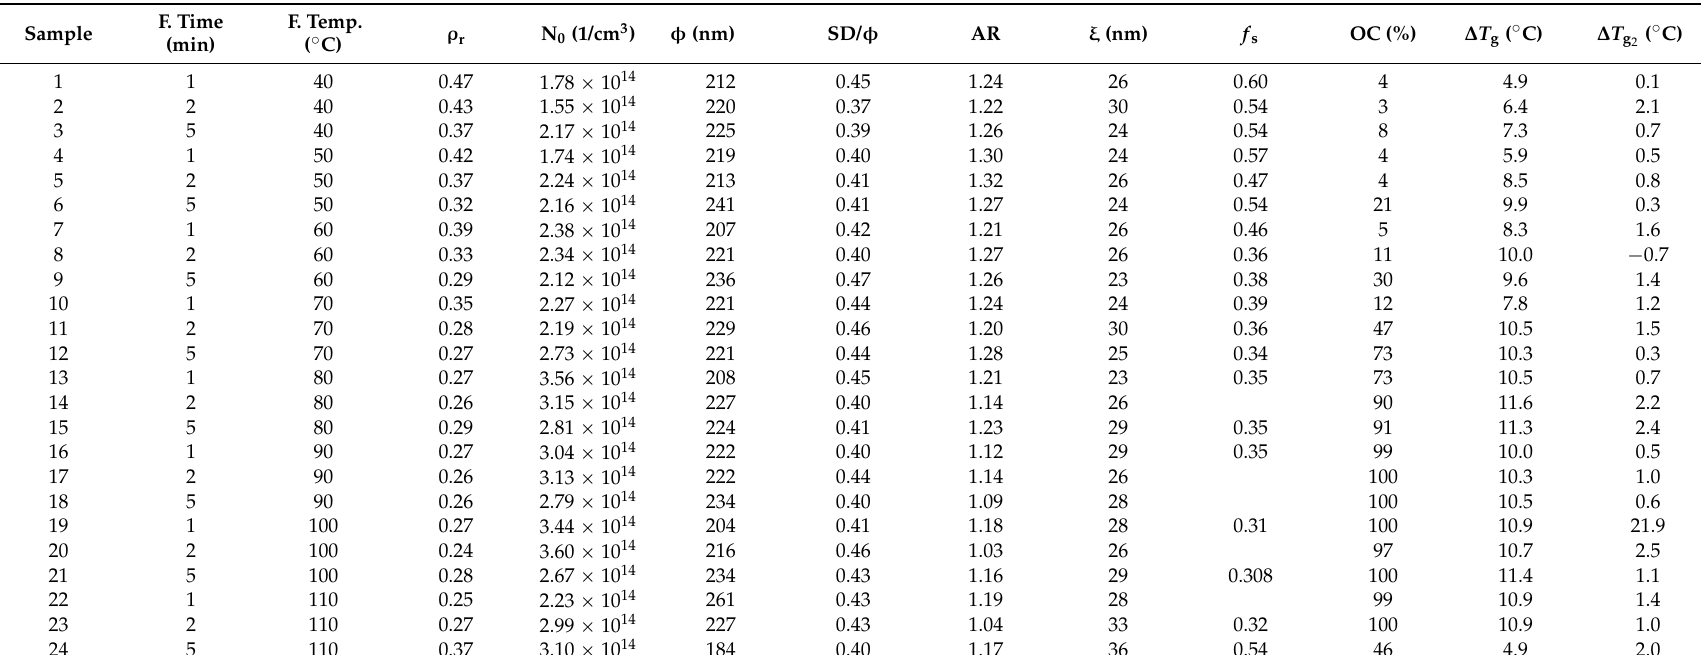
Table 1. Production parameters and main characteristics of the materials under